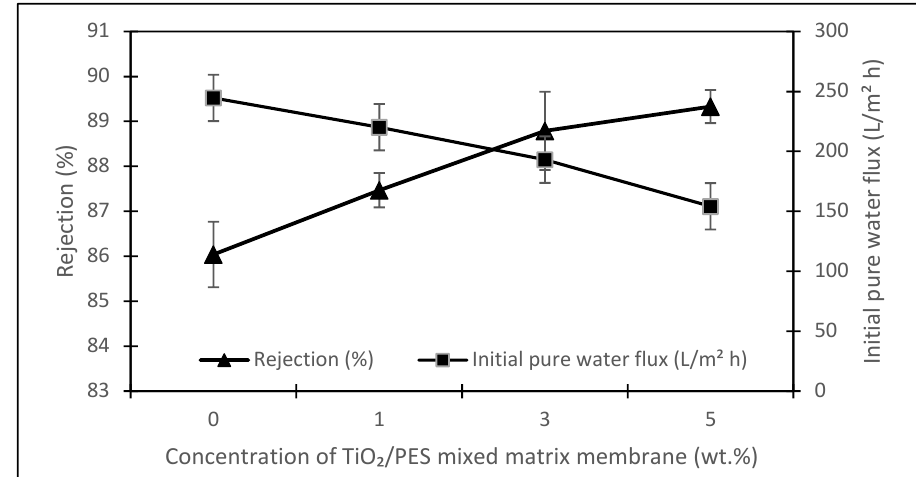
Figure 6. Humic acid rejection and initial pure water flux for each TiO 2 /PES mixed matrix membrane concentration.